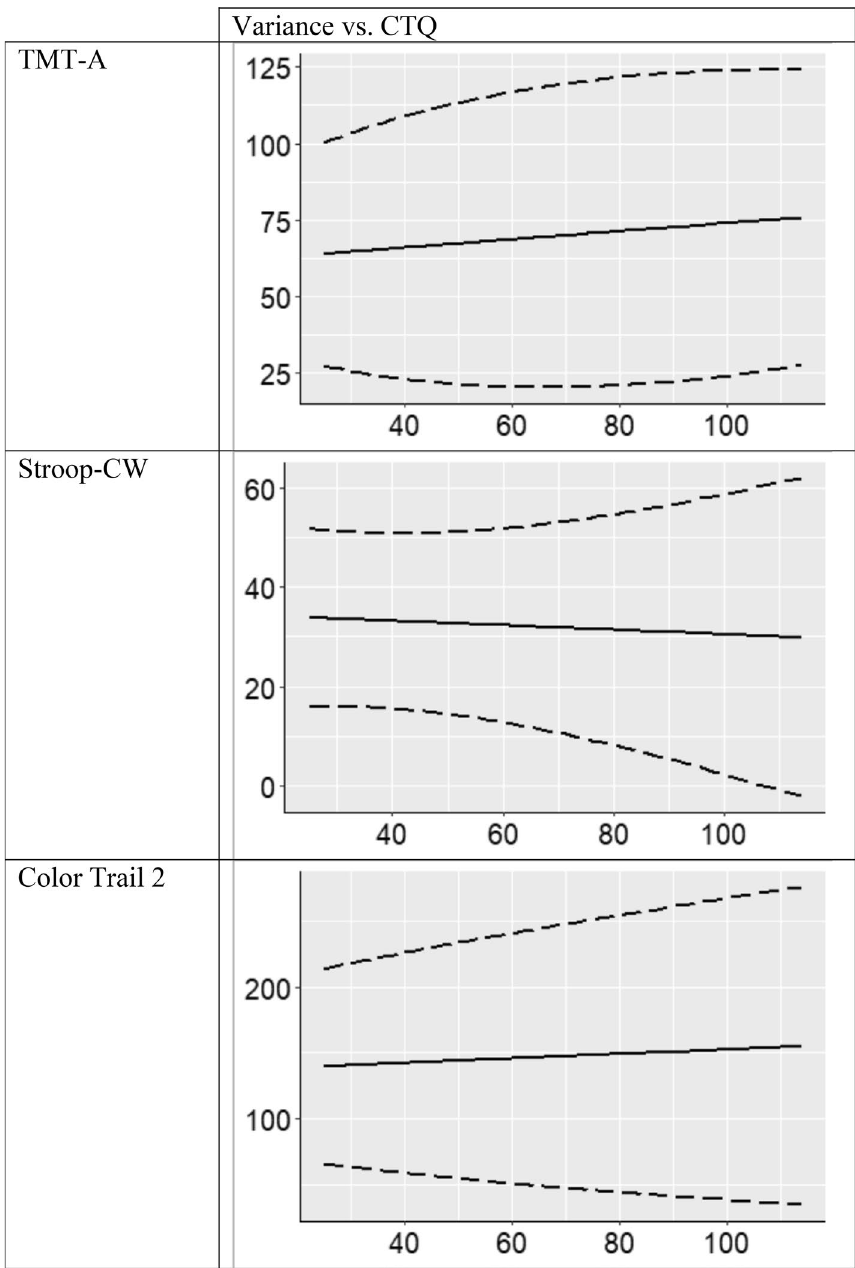
Figure 1. Predicted values of neurocognitive performance by CTQ score derived from complex level-1 models demonstrating statistically significant patterns of individual-level heterogeneity. Dotted lines delineate the upper and lower bounds wherein 95% of observed neurocognitive performance scores by CTQ level lie 1.96 √ Var ( NP ) ( ± ×